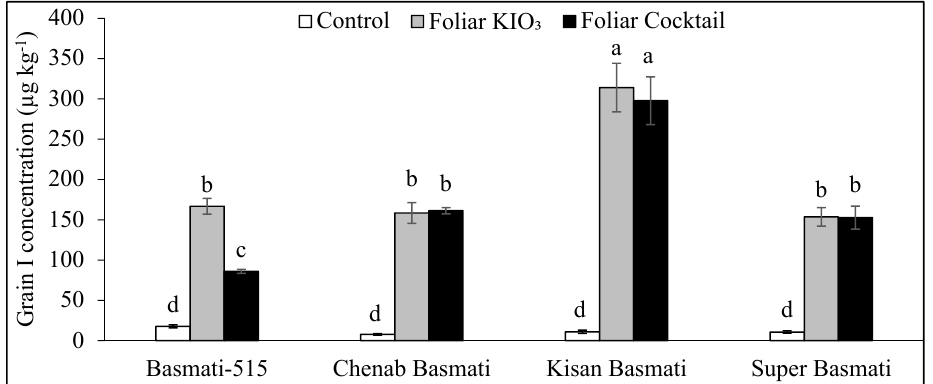
Figure 1. Effect of foliar sprays of KIO 3 (0.05%) alone or contained in a cocktail together with ZnSO 4 ∙ 7H 2 O (0.5%) and Na 2 SeO 4 (0.0024%) on I concentration in brown rice grains of different Basmati rice cultivars. Control, two foliar sprays of distilled water; Foliar KIO 3 , two foliar sprays of 0.05% KIO 3 ; Foliar Cocktail, two foliar sprays of a mixture of 0.05% KIO 3 , 0.0024% Na 2 SeO 4 and 0.5% ZnSO 4 ∙ 7H 2 O. Bars (mean ± SE) having different letters differ significantly at p = 0.05. LSD: Cultivar = 23.9, Treatment = 20.7, Cultivar × Treatment = 41.4.